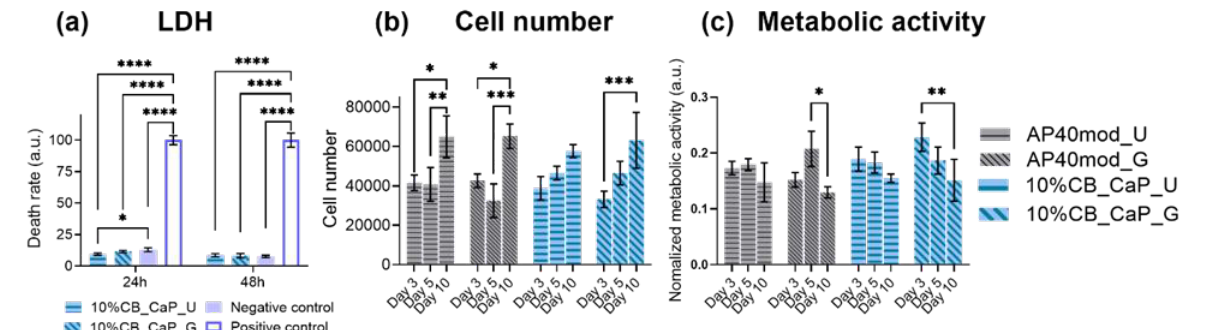
Figure 8. Cytotoxcity ( a ) of the scaffold of 10%CB-CaP at 24 h and 48 h, cell proliferation ( b ) and metabolic activity ( c ) of hMSCs on day 3, 5 and 10 of cell culturing. N = 8; * p < 0.05; ** p < 0.01; *** p < 0.001; **** p < 0.0001. U: uniform pores; G: gradient pores.